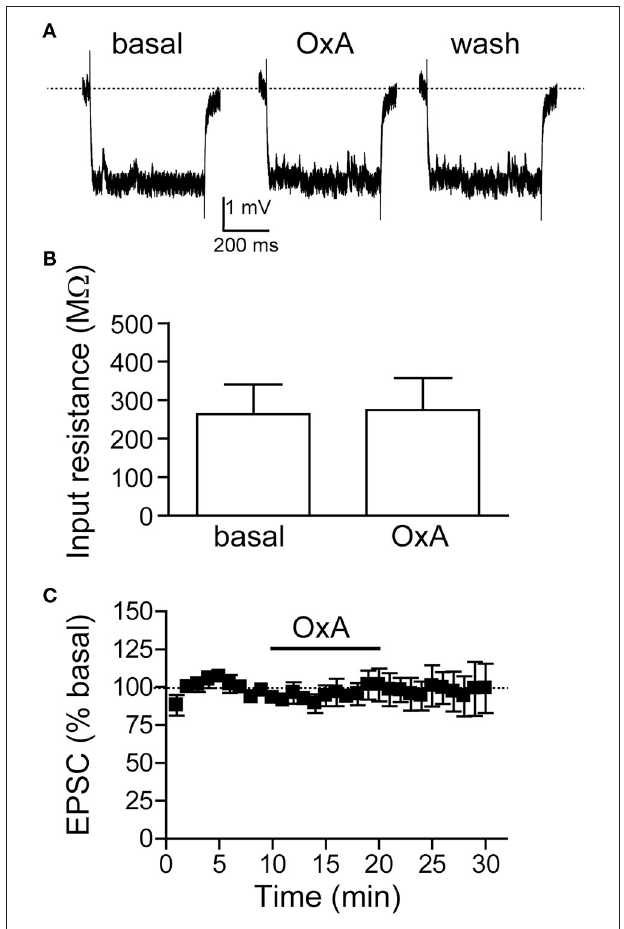
FIGURE 9 | OrexinA ex vivo did not alter input resistance or evoked EPSCs in medial NAc Shell neurons from alcohol-drinking mice. (A,B) Examples (A) and grouped data (B) showing that OxA did not change input resistance (30 pA hyperpolarizing step). (C) Plot across time showing that OxA did not change evoked EPSCs at −